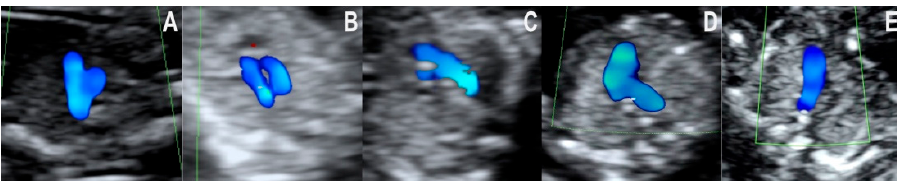
Figure 2. Color doppler flow patterns encountered in the three-vessel and trachea view. ( A ): Typical V sign with equally sized arms. ( B ): The vessels forming a U sign around the trachea. ( C ): V sign with a narrower arm. ( D ): One vessel with an oblique and curved course. ( E ): One vessel with a straight course.